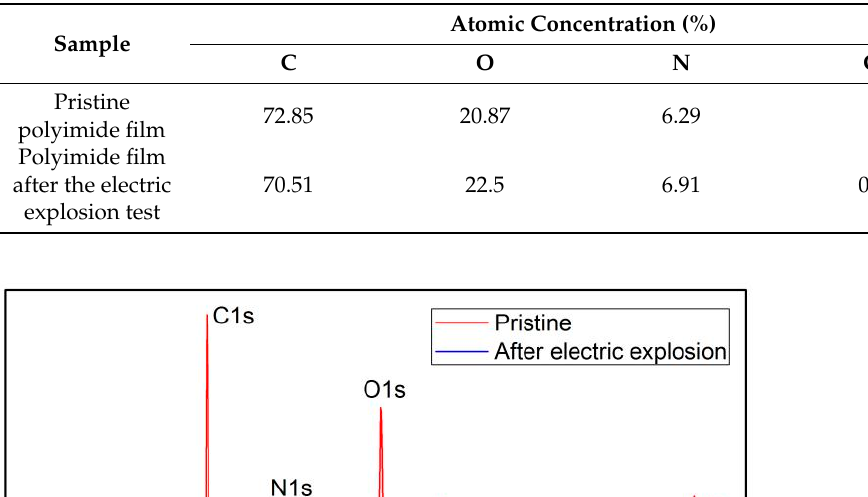
Table 2. The atomic ratio of C, O, and N in pristine polyimide film and the sample after the electric explosion test.